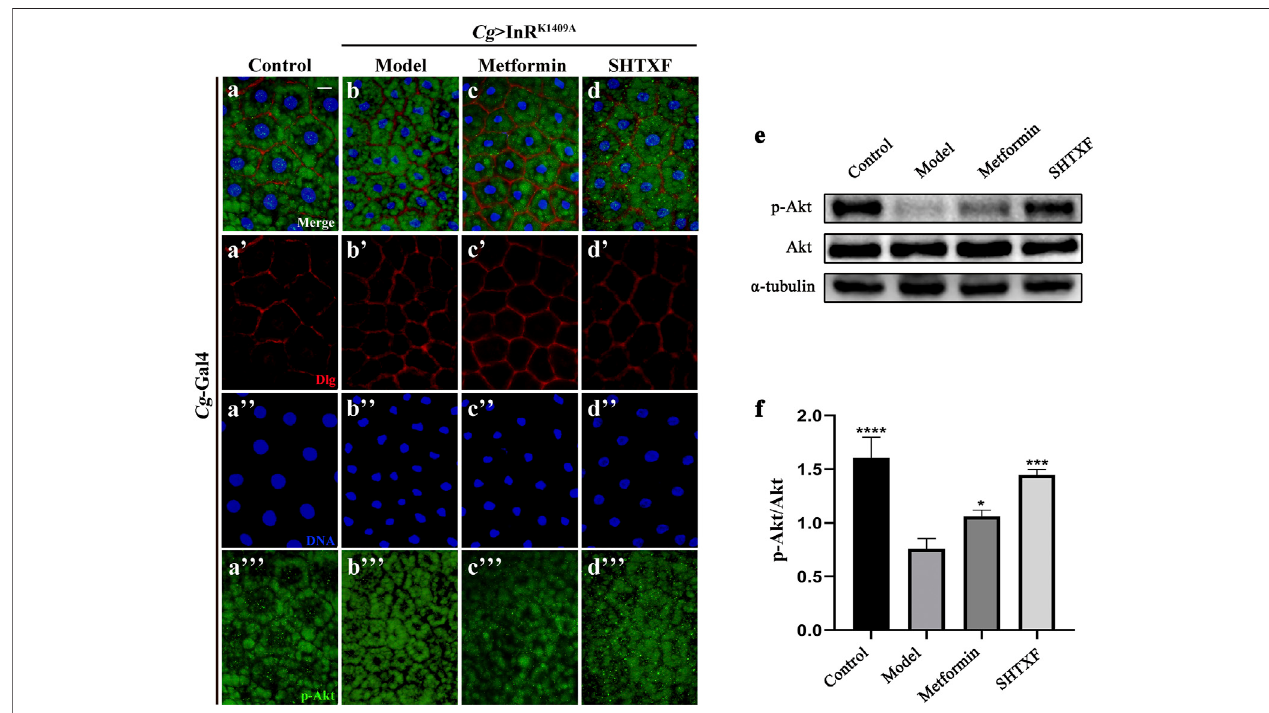
FIGURE 6 | SHTXF increases the level of Akt phosphorylation. (A – D) Merged fl uorescence micrographs of Drosophila third-instar larval fat body are shown. The individual channels detect only Dlg [red, (A ’– D ’ ) ],only DAPI [blue, (A ’’– D ’’ ) ],and only p-Akt [green, (A ”’– D ”’ ) , fl uorescent dots]. (E) Western blot analysis ofwhole-body extracts from third-instar larvae for phosphorylated Akt, total Akt, and α -tubulin (9 larvae per time). α -tubulin was used as a loading control. Groups (from left to right): Control ( Cg -Gal4/+), Model ( Cg -Gal4/+; UAS -InR K1409A /+), Metformin ( Cg -Gal4/+; UAS -InR K1409A /+ fi les treated with 10 mM metformin), SHTXF ( Cg -Gal4/+; UAS -InR K1409A /+ fi les treated with 0.025 g/ml SHTXF). (F) Statistical analysis of the p-Akt/Akt relative level from three independent experiments is shown in (E) ( n = 3). Theerrorbarsindicatethestandarddeviation. One-wayANOVAwithBonferroni ’ smultiplecomparisontestwasusedtocompute p values:**** p < 0.0001,*** p < 0.001, and * p < 0.05. Scale bar, 20 μ m (A – D) . Genotypes: (A) Cg -Gal4/+ and (B – D) Cg- Gal4/+; UAS -InR K1409A